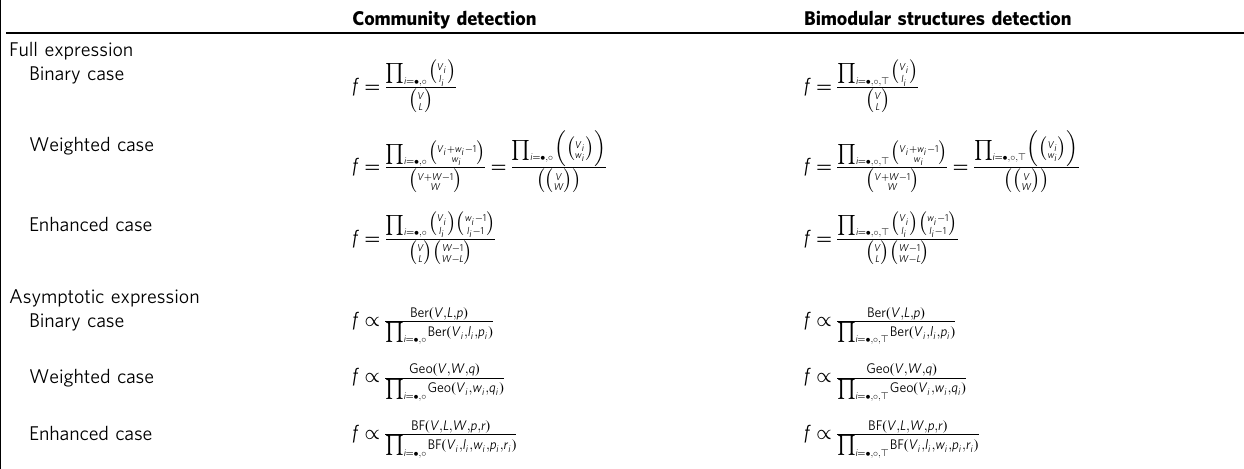
Table 1 Table illustrating all the generalizations of the surprise-based formalism proposed in the present paper. Community detection Bimodular structures